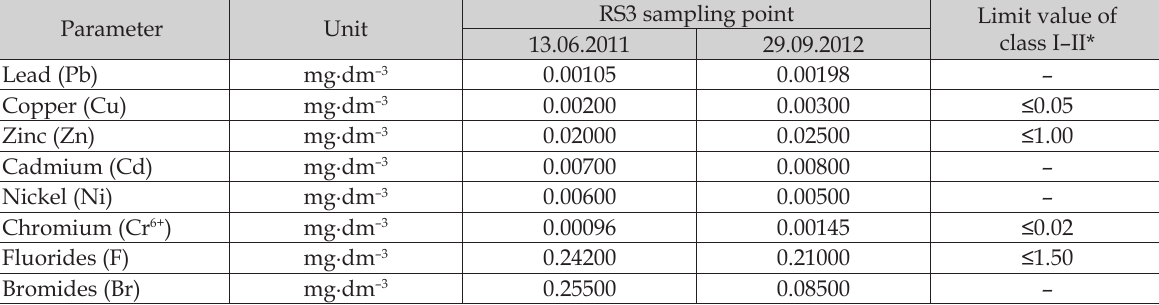
Table 2. Heavy metal, fluoride and bromide concentrations in the Różany